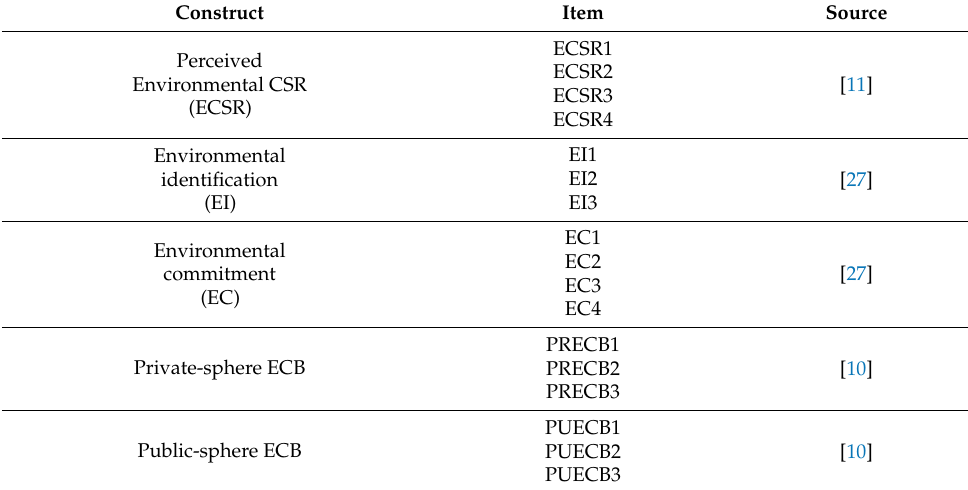
Table 1. Measurement items.